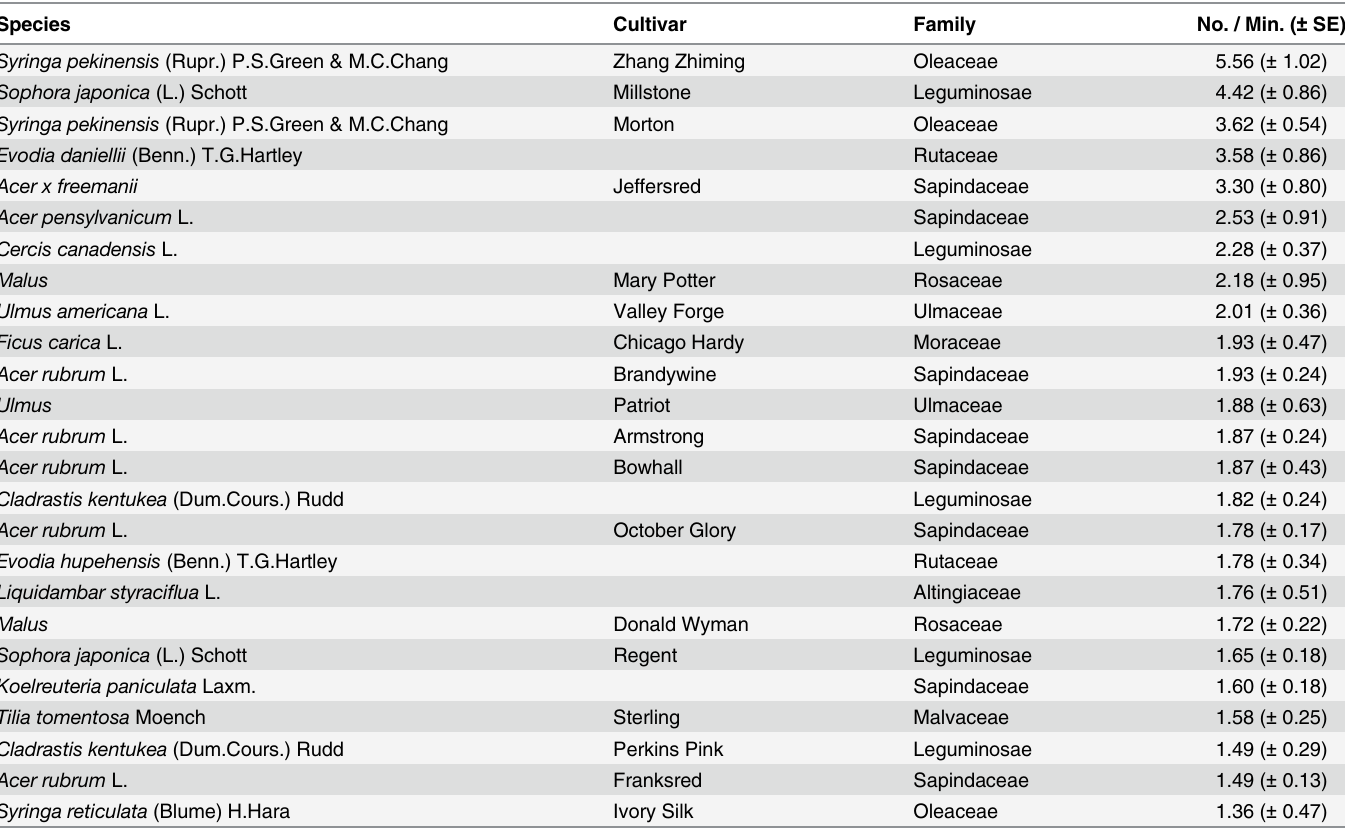
Table 2. Top hosts for nymph and adult Halyomorpha halys . Mean total abundance ( ± SE) of nymphs and adults per 1 min. survey (No. / Min.) for the top twenty-five plant taxa classified as hosts (~10% of all sampled